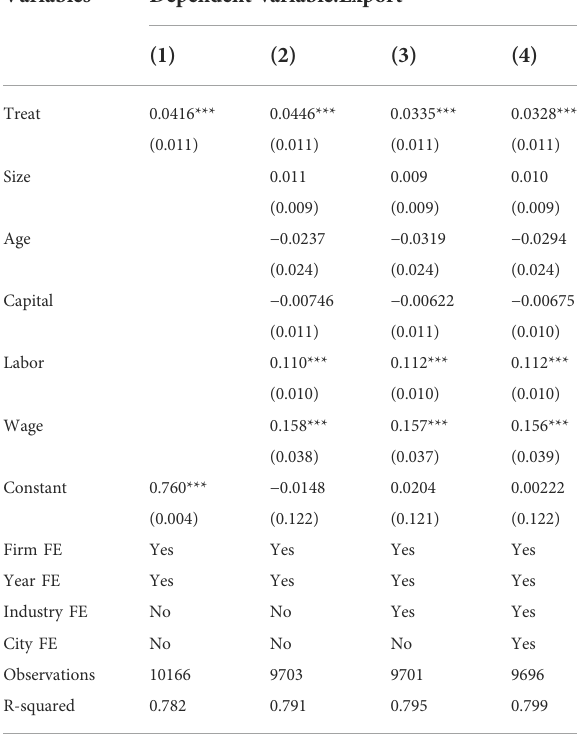
TABLE 2 The baseline